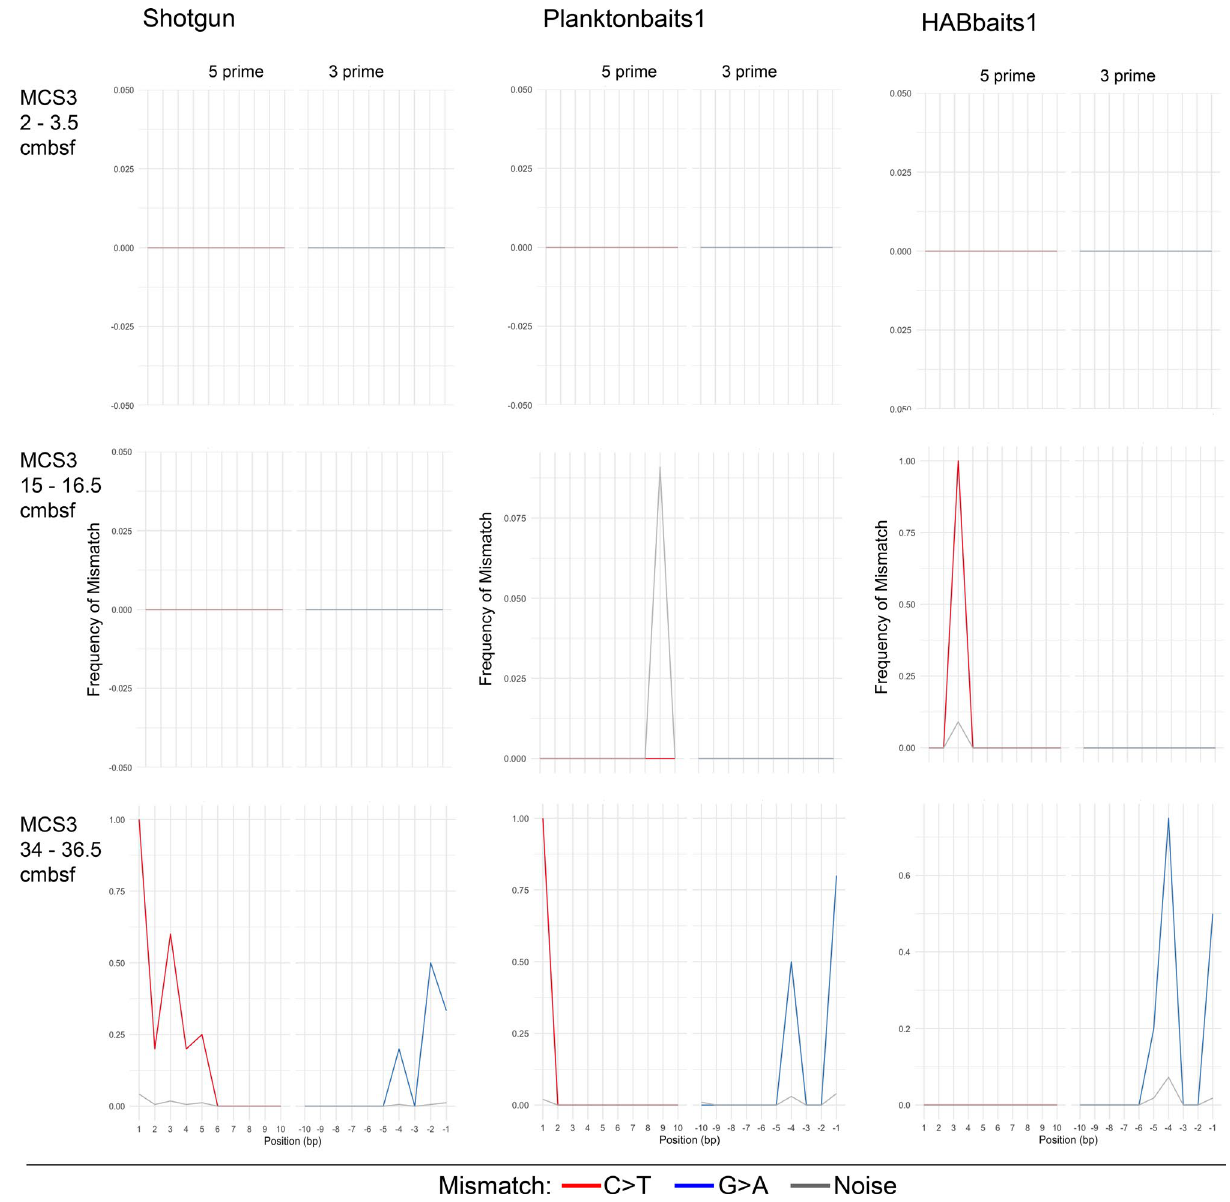
Figure 5. Sed aDNA damage profiles of Emiliania huxleyi in MCS3 . E. huxleyi sed aDNA damage profiles (frequency of mismatch against base pair position) per sample for Shotgun, Planktonbaits1 and HABbaits1 in MCS3. The red and blue lines denote C > T substitutions in 5 ′ direction and G > A substitutions in 3 ′ direction, respectively, for all ancient alignments. Grey lines denote estimated noise 23 . Shown are selected samples only (top, mid-depth and bottom sample), for damage profiles of all samples see Supplementary Material Fig.